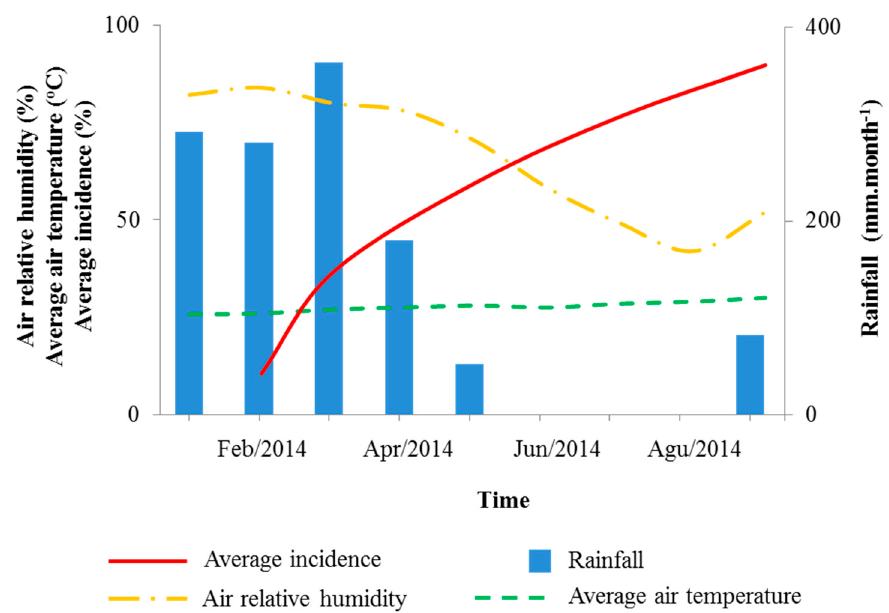
Figure 5. Bacterial leaf blight incidence (monthly average) in eucalyptus, rainfall (accumulated in the month), air relative humidity (monthly average) and average air temperature (monthly average) recorded between February and September 2014.